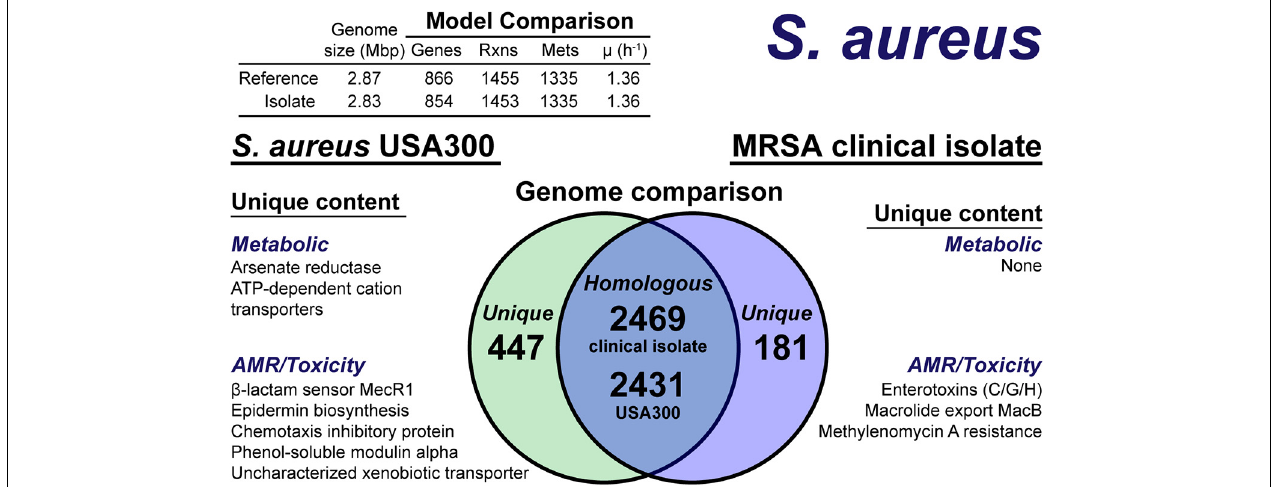
FIGURE 4 | Comparison of S. aureus USA300 TCH1516 versus the S. aureus clinical isolate based on outputs of the genome-scale metabolic reconstruction